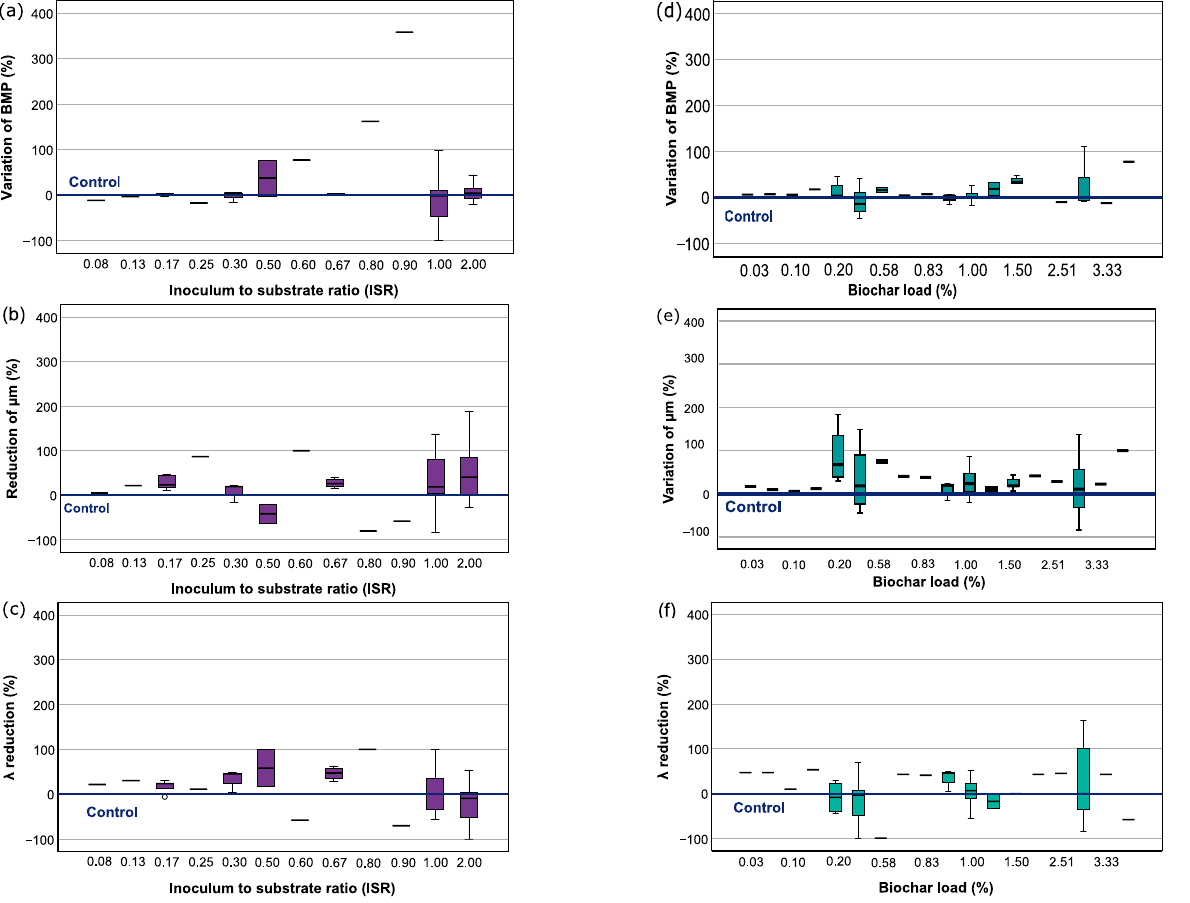
Figure 5. Box plot for the distribution of the relation between the variables for digestion conditions composition and their effect in anaerobic digestion parameters: Effect of inoculum to substrate ratio (ISR) on BMP ( a ), µ m ( b ) and λ reduction ( c ); effect of biochar load (BCL) on BMP ( d ), µ m ( e ), and λ reduction ( f ).